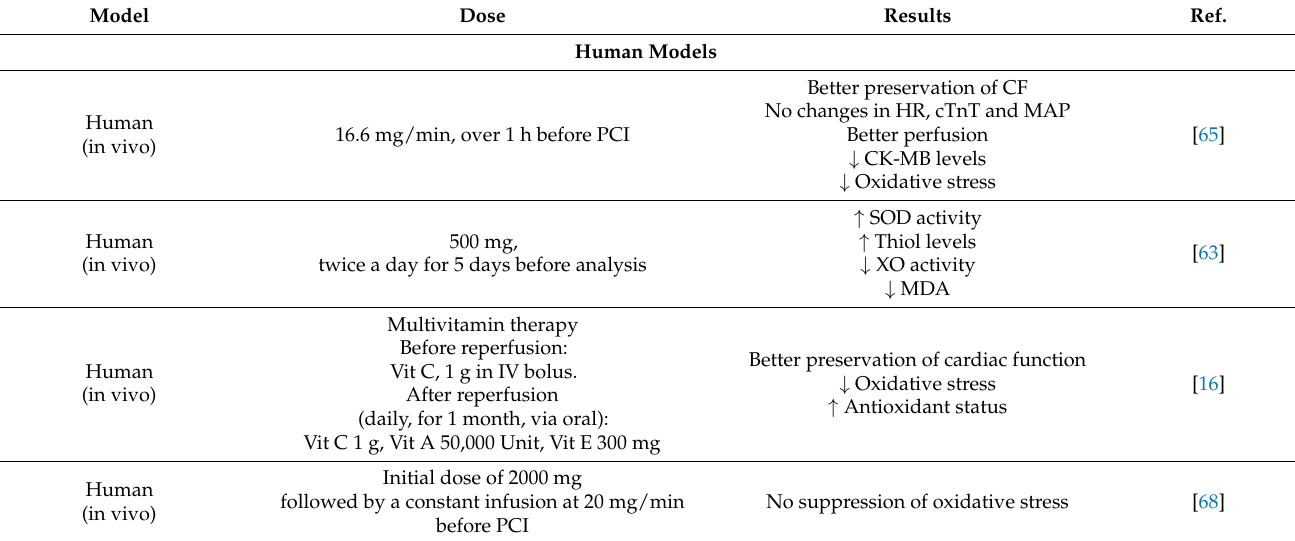
Table 1. Results of the use of Vit C alone or in association with other antioxidants. Model